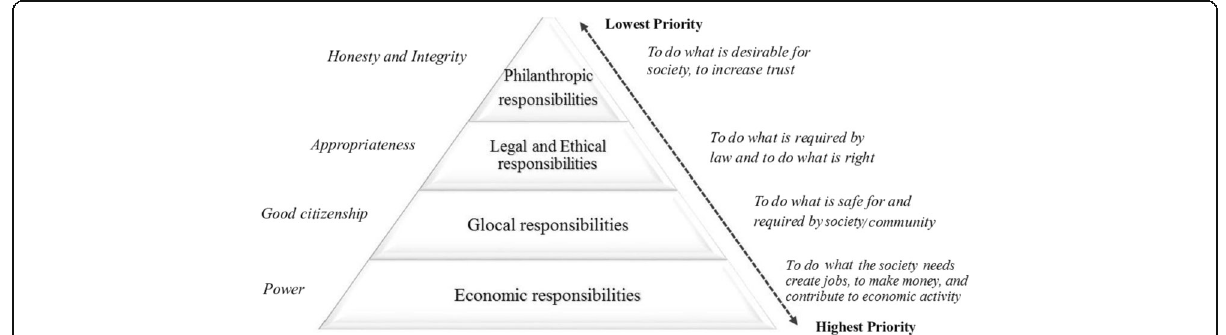
Fig. 8 International Pyramid Model of CSR Source: Developed by the author,